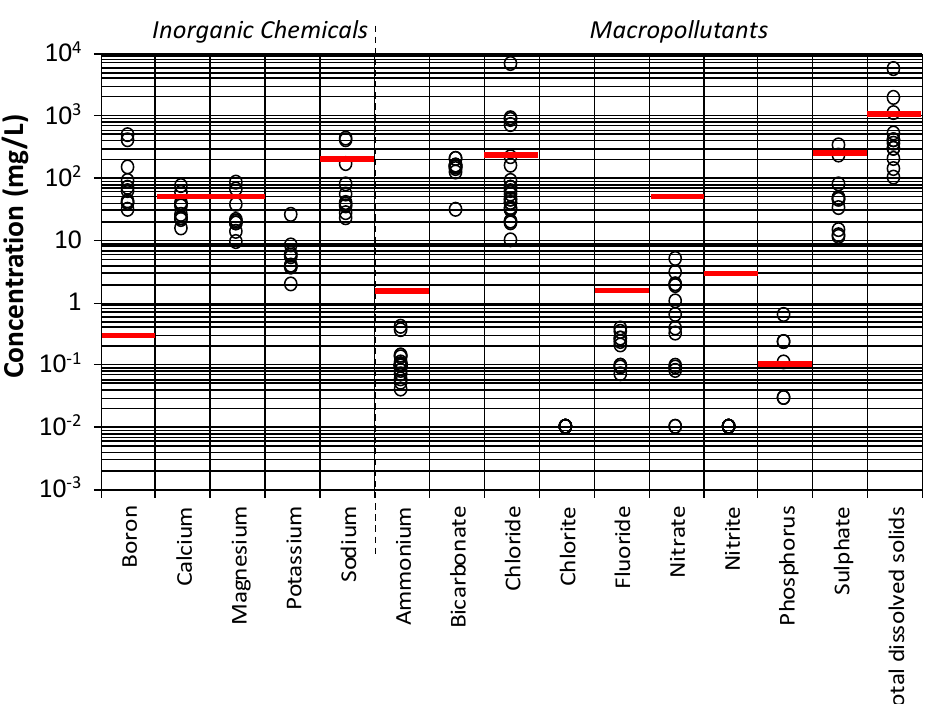
Figure 3. Observed concentrations (circle) of inorganic chemicals, macropollutants, and total PAHs in surface water in the reviewed studies referring to RSA and the corresponding limits (red dashes) set by SANS-241 for drinking water. Data from: [3,30–34,36–39,41,42,44,50].